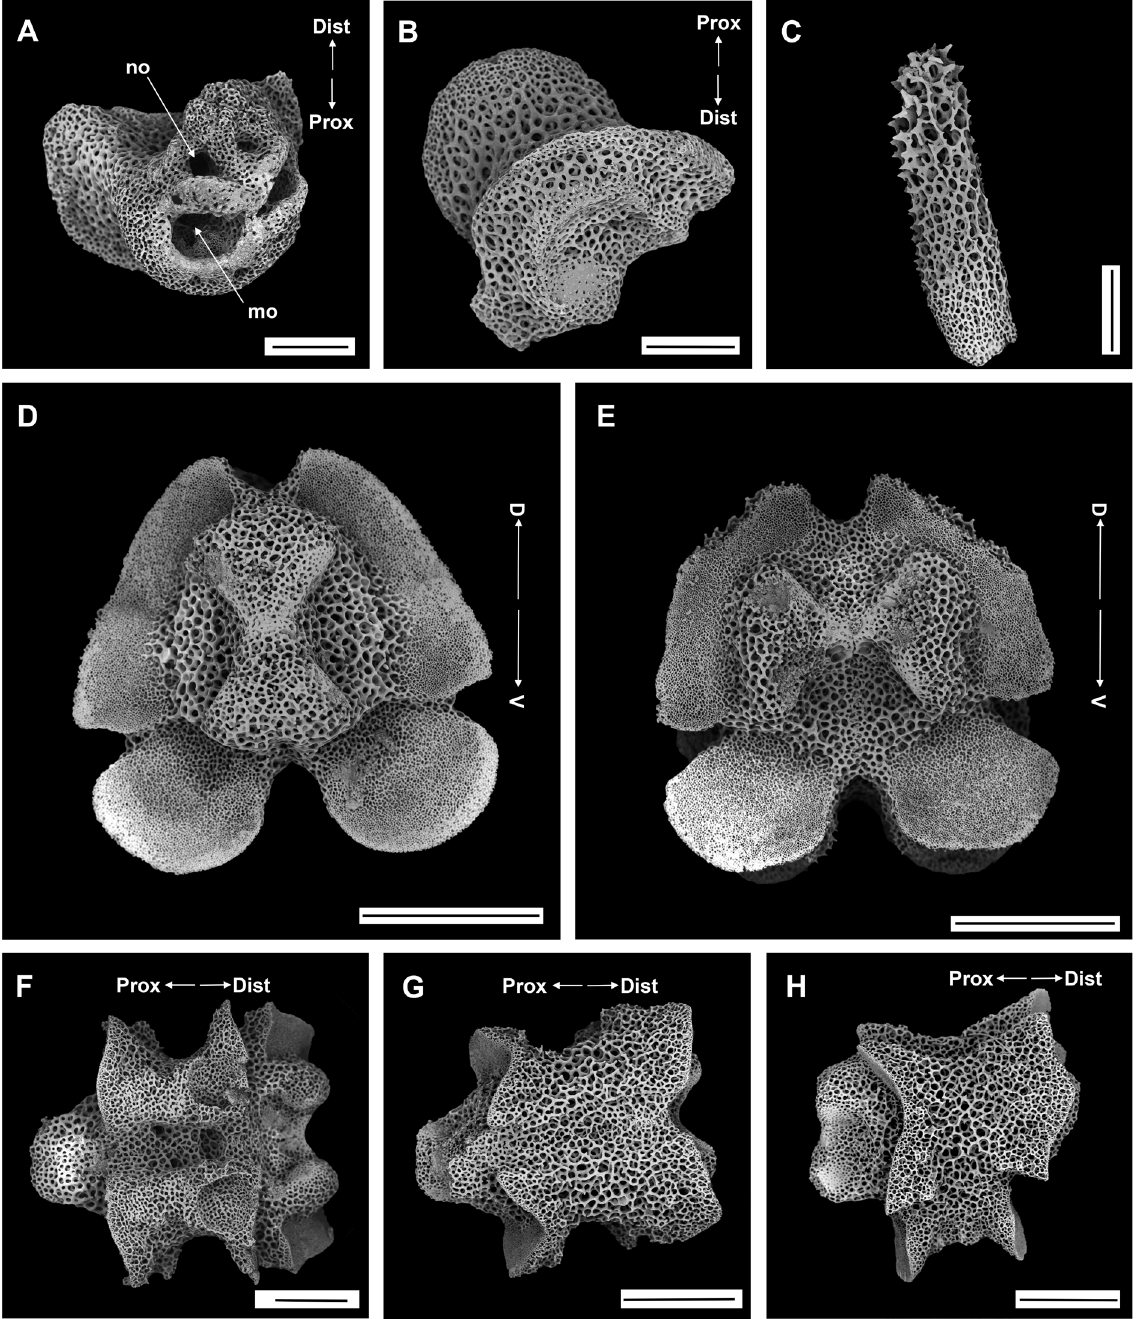
Fig. 8. Asteroschema horridum Lyman, 1879, SEM (IDSSE EEB-SW0005). A–B . Lateral arm plate (external, internal). C . Arm spine. D–H . Vertebrae. D . Proximal view. E . Distal view. F . Ventral view. G . Dorsal view. H . Lateral view. Abbreviations: D = dorsal; Dist = distal; Prox = proximal; mo = muscle opening; no = nerve opening; V = ventral. Scale bars: A–C, F = 300 µm; D–E, G–H = 500